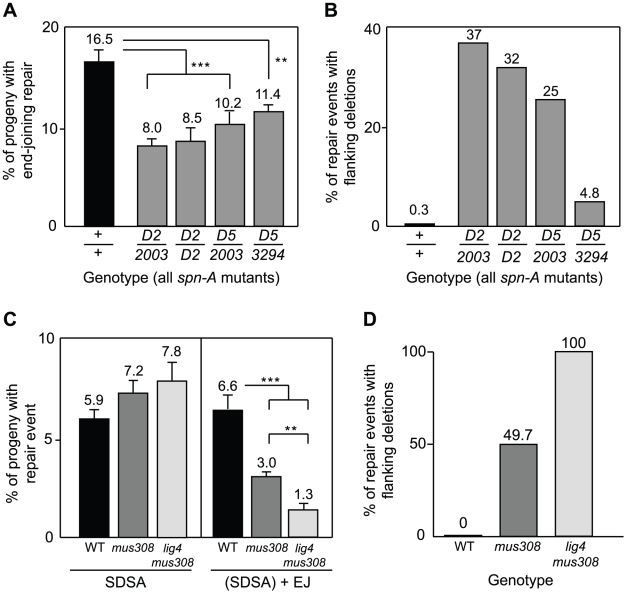
Pol θ–dependent end joining acts independently of HR and C-NHEJ.(A) Decreased end joining in mus308 mutants does not depend on homologous recombination. Each bar represents the mean percentage of end-joining events recovered from independent males of each genotype. Number of independent males assayed: spn-A = 63; spn-A057mus308D2/spn-A057mus3082003 = 216; spn-A057mus308D2/spn-A057mus308D2 = 33; spn-A093mus308D5/spn-A057mus3082003 = 80; spn-A093mus308D5/spn-A093mus3083294 = 128. Error bars represent SEM. ** indicates p<0.01, *** indicates P<0.001 (Kruskal-Wallis non-parametric ANOVA). (B) Genomic deletions during DSB repair in mus308 mutants do not depend on initiation of HR. Each bar represents the percentage of yellow-eyed female progeny with scalloped wings (representing large flanking deletions) recovered from males of indicated genotype. (C) Mutation of mus308 in a lig4169a background further reduces end-joining repair relative to mus308 single mutants. Each bar represents the mean percentage of repair events recovered from wild type, mus3082003/Df(3R)kar3l, or lig4169a; mus3082003/Df(3R)kar3l males. Number of independent males assayed: wild type = 101, mus308 = 182, lig4 mus308 = 57. Error bars represent SEM. ** indicates p<0.01, *** indicates P<0.001 (Kruskal-Wallis non-parametric ANOVA). (D) Genomic deletions always occur during DSB repair in lig4 mus308 mutants. All yellow-eyed repair events recovered from lig4169a; mus3082003/Df(3R)kar3l males had large deletions that resulted in male lethality and/or female progeny with scalloped wings. Number of independent repair events assayed: wild type = 101, mus308 = 167, lig4 mus308 = 22.